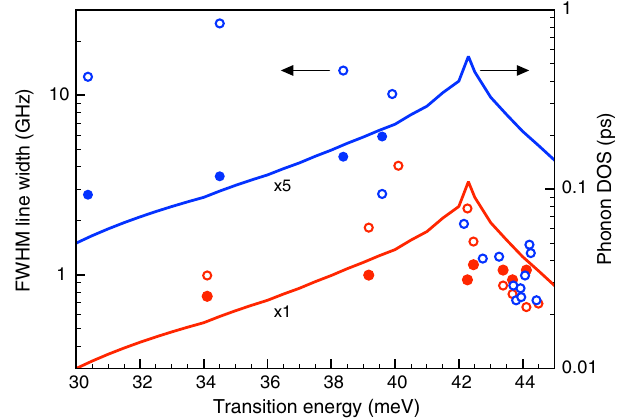
FIG. 9. The FWHM linewidth from the FTIR of isotopically pure 28 Si from Ref. [17] (open symbols) and inverse lifetime 1 = 2 (cid:2)T 1 at low pumping power from this work and Ref. [15] (solid symbols) for various Si:P (red) and Si:B (blue) transitions versus transition energy. In the case of the Si:B FTIR, only transitions that are strong and well isolated from other transitions have been included here. The phonon DOS (solid lines) has been scaled by the values indicated on the